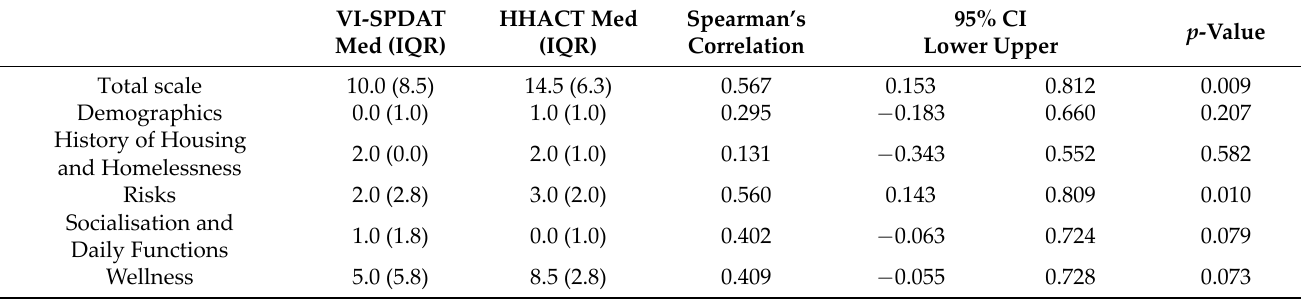
Table 4. Convergent